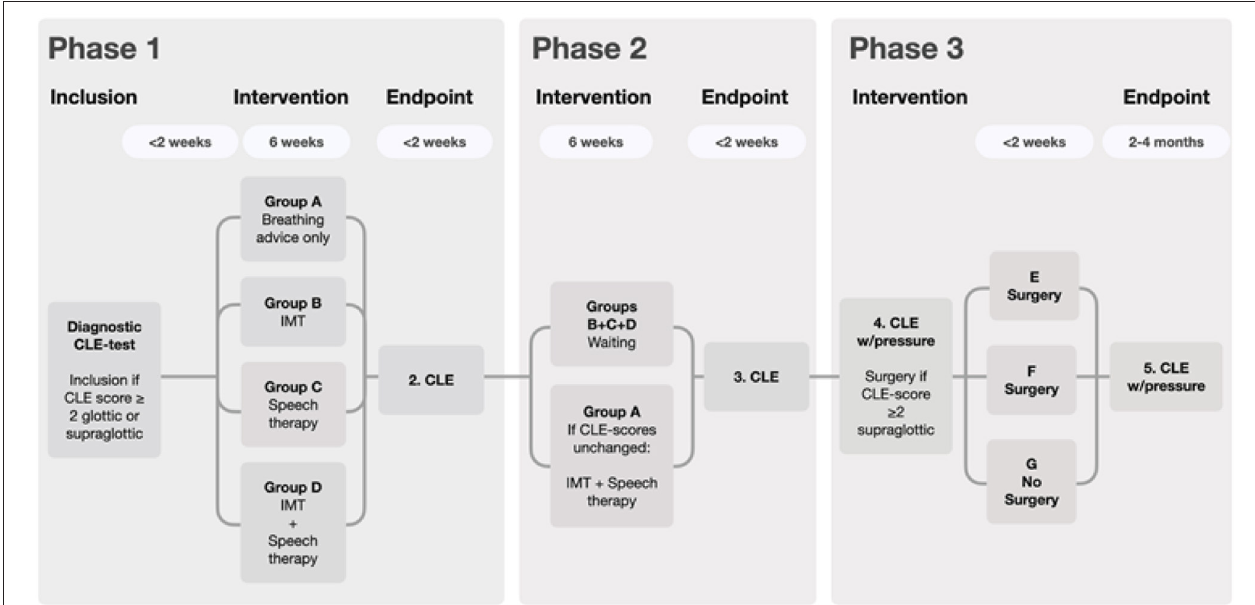
FIGURE 2 | Flow chart depicting the four non-invasive approaches and two different surgical approaches. During Phase 1, breathing advice will be provided to all groups, and constitutes the only measure in group A, serving as reference for the groups B, C, and D.